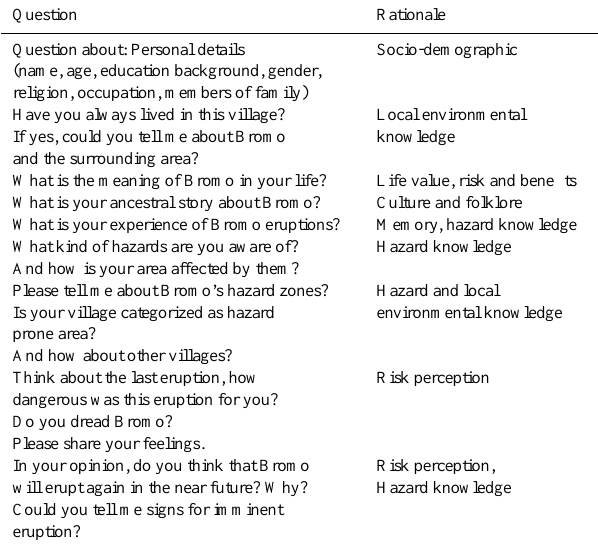
Table 3. Questions asked during semi-structured interviews and fo- cus group discussion.